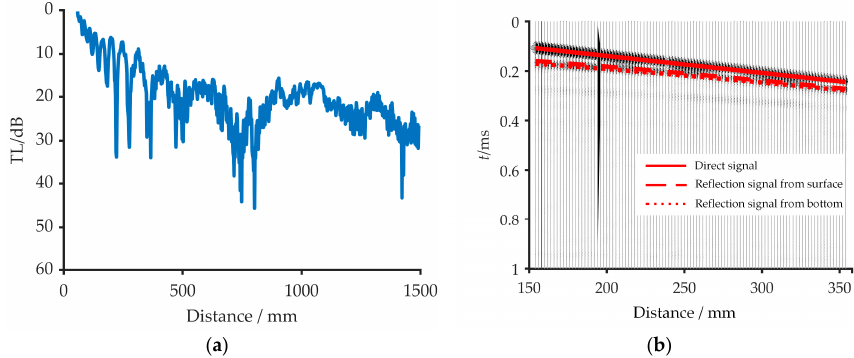
Figure 13. ( a ) The TL measured in the experiment; ( b ) The arrival time of the signal. The red line represents the arrival time of the direct signal, the dashed red line means the arrival time of surface reflection signal, and the dotted red line means the arrival time of the bottom reflection